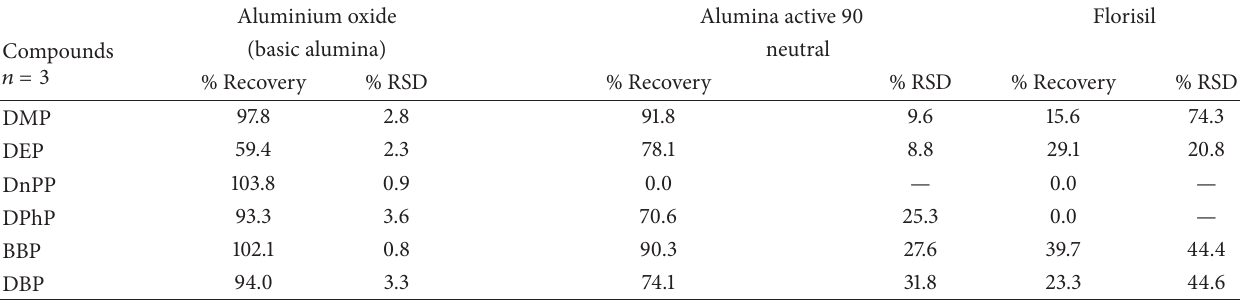
Table 3: Effect of the fat retainers on the recovery and repeatability of phthalate extraction from spiked samples (1mg/L).